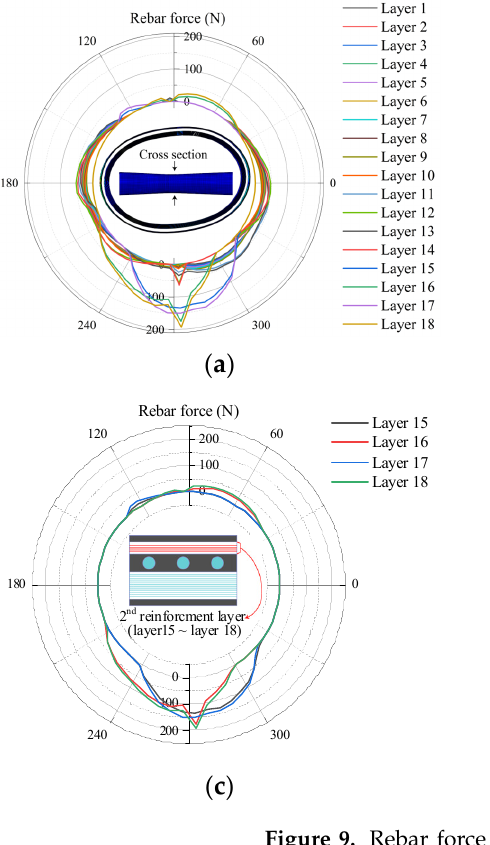
Figure 9. Rebar force of the cord after collapsed: ( a ) full cords, ( b ) inner cords, ( c ) outer cords, ( d ) maximum of the force in each cord.